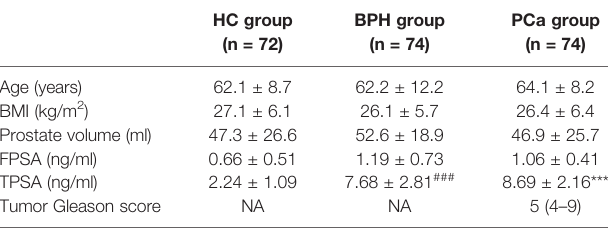
TABLE 1 | Characteristics of the individuals included in this